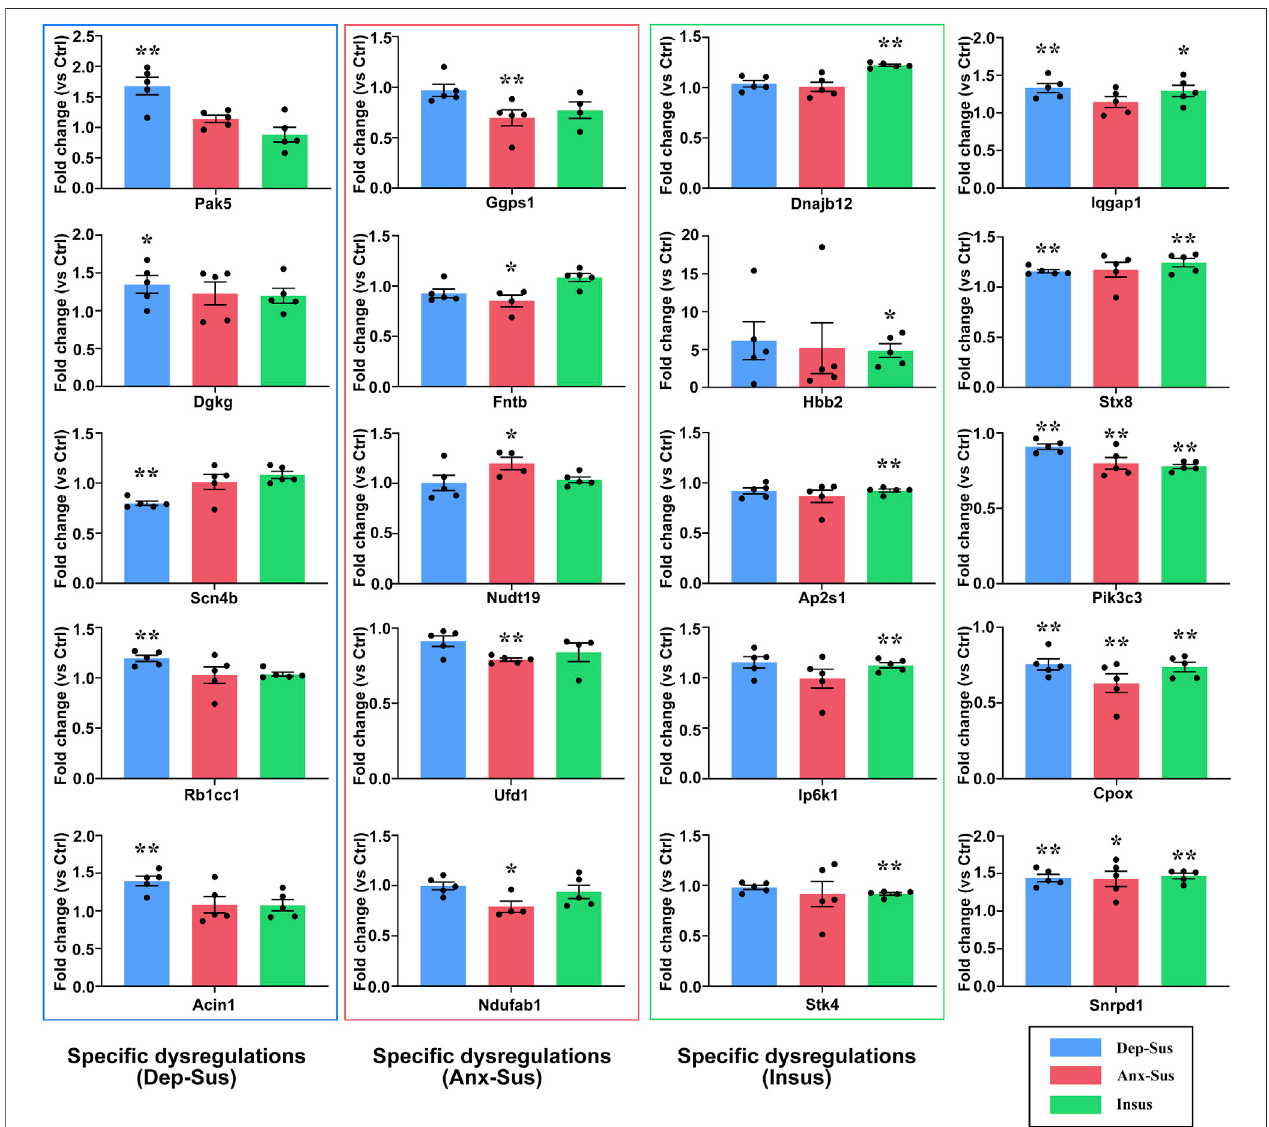
FIGURE 5 | PRM analysis of the abnormally expressed proteins in the three groups (Dep-Sus, Anx-Sus, and Insus) compared with the control (Ctrl) group. Pak5, Dgkg, Scn4b, Rb1cc1, Acin1, Ggps1, Fntb, Nudt19, Ufd1, Ndufab1, Dnajb12, Hbb2, Ap2s1, Ip6k1, Stk4, Iqgap1, Stx8, Pik3c3, Cpox, and Snrpd1 were examined on the striatal protein extracts of the rats ( n (cid:2) 4 – 5 per group). * p < 0.05, ** p <